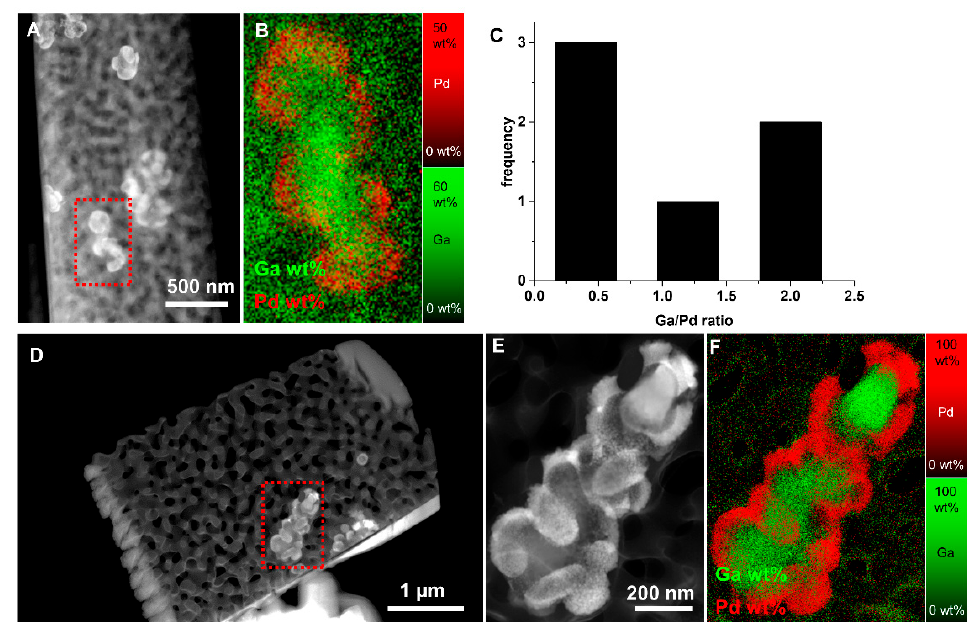
Figure 7. STEM-EDXS analysis of the 360°-ET pillar and the thin lamella of sample routines 1 and 3 (Table 1). ( A ) HAADF STEM image of the pillar of sample routine 1 revealing the distinct structure of the Ga-Pd droplets embedded in the porous glass network. ( B ) STEM-EDXS map of an exemplary particle marked in ( A ) showing a core/shell structure with a Ga-rich phase in the center and a Pd-rich phase in the surrounding areas (chemical composition is displayed in wt% scaling with the color intensity from dark to bright). ( C ) Frequency of measured Ga-Pd ratios ranging from 0.14 to 1.98 determined from 6 individual droplets. ( D ) HAADF STEM image of the TEM lamella (450 nm thickness) from sample routine 3, enabling STEM-EDXS with higher resolution and precision due to reduced beam broadening and electron/X-ray absorption. ( E ) HAADF STEM image and ( F ) STEM-EDXS map (chemical composition is displayed in wt% scaling with the color intensity from dark to bright) of one droplet from the lamella marked with a red rectangle in ( D ) at higher magnification.